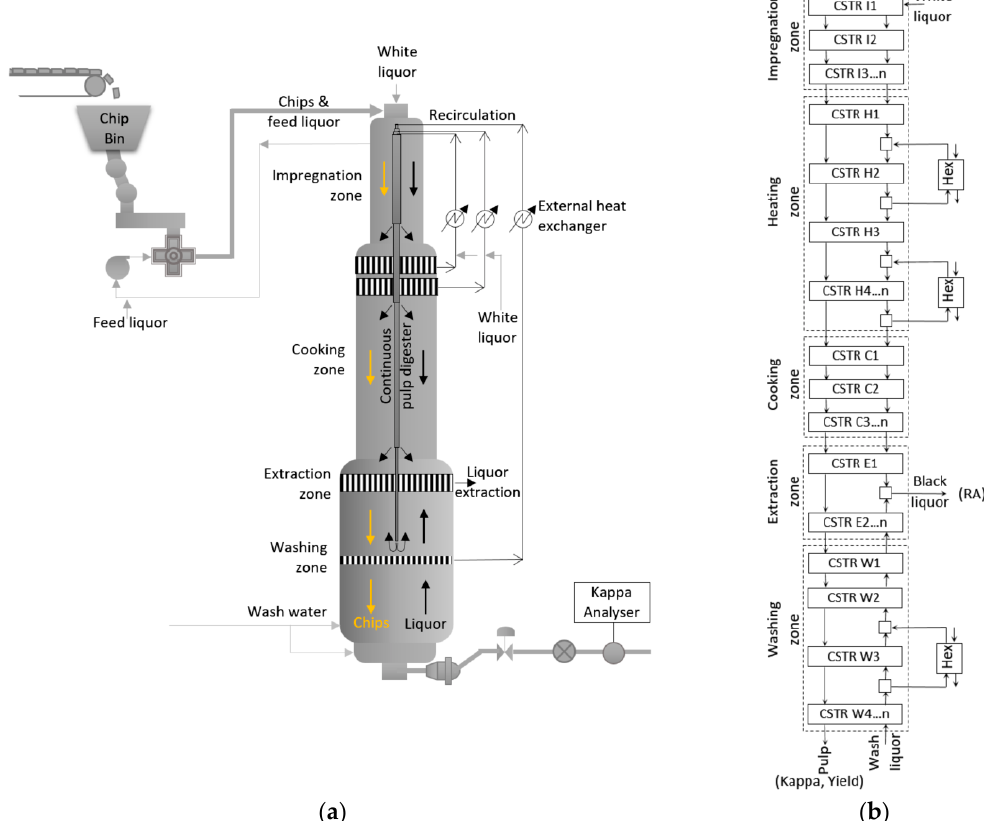
Figure 1. ( a ) Schematic of a continuous digester process flow and ( b ) conceptual model architecture.